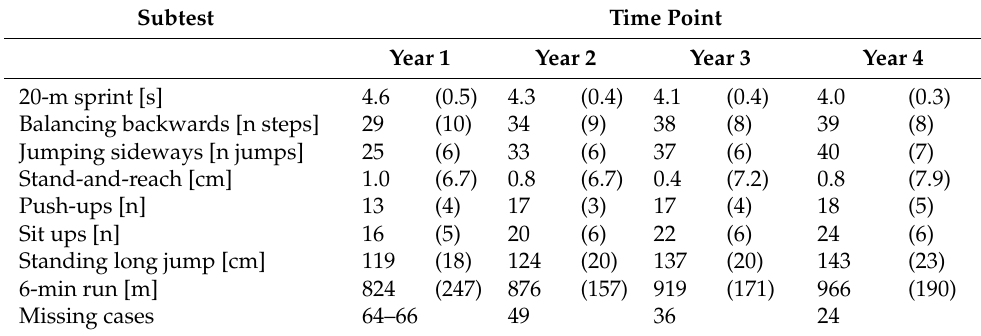
Table 1. Mean (SD) raw values of all physical fitness subtests over 4